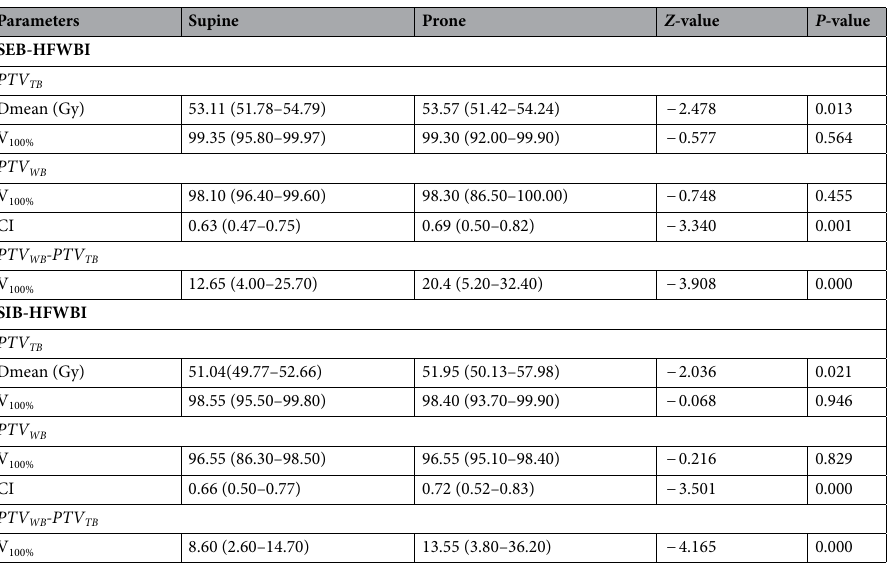
Table 6. Dosimetric evaluation of the targets for the SEB-HFWBI or SIB-HFWBI treatment plan in the supine and prone positions (median). TB tumor bed, PTV TB planning target volume for TB, WB whole breast, PTV WB planning target volume for WB, PTV WB -PTV TB the target volume obtained by subtracting the PTV TB from the PTV WB , SIB simultaneous integrated boost, SEB sequential integrated boost, HFWBI hypofractionated whole- breast irradiation, CI conformal index, Dmean mean dose, V100% the PTV coverage percent of the 100% prescribed dose line including PTV TB, PTV WB, PTV WB -PTV TB in the treatment plan under supine and prone